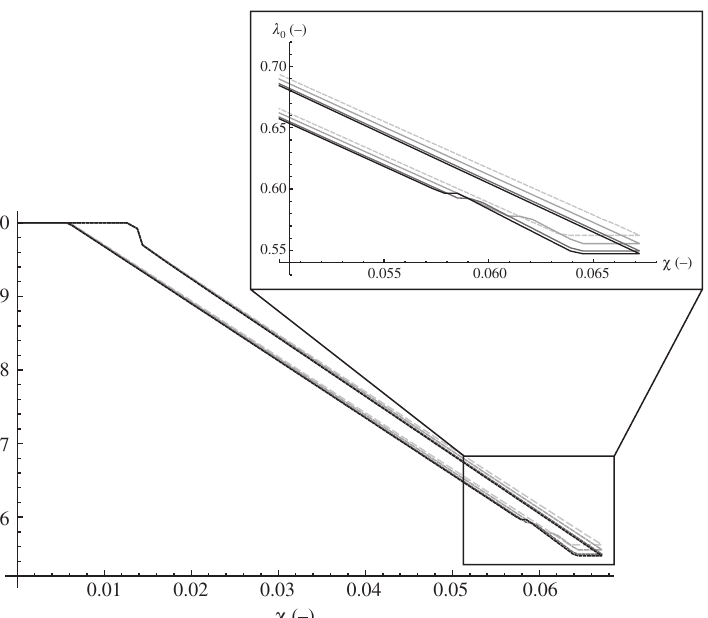
Figure 2 Volume fraction of austenite over strain with varying heat conductivity κ ∈ {0.010, 0.015, 0.030, 0.050} GPa/K, including a zoom of the end region.